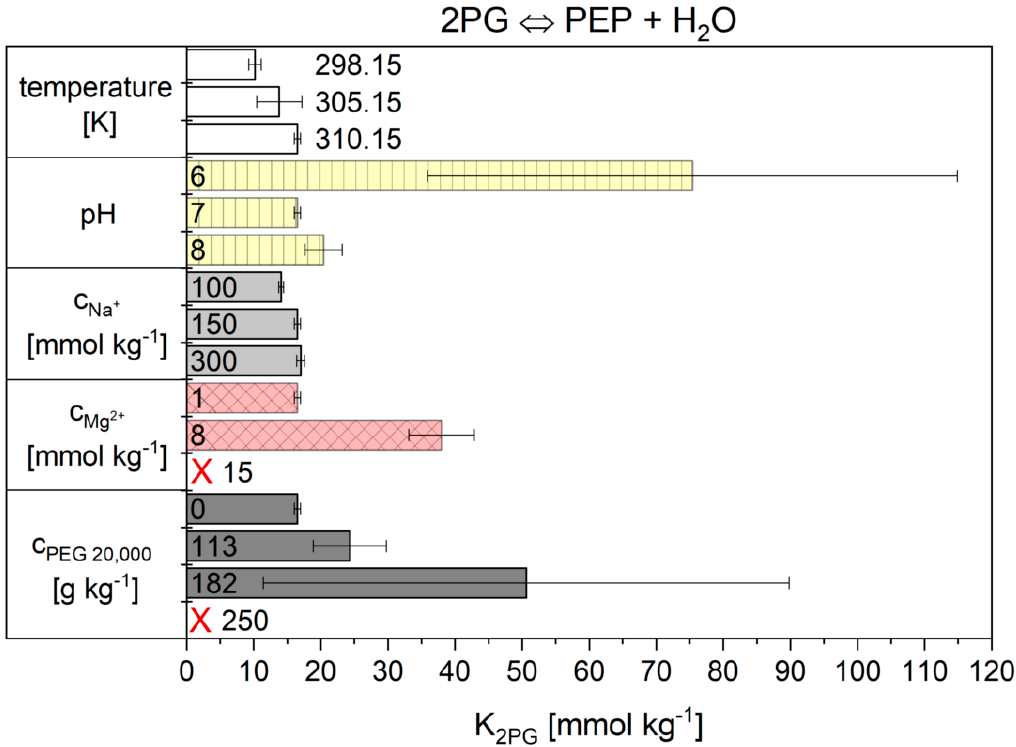
Figure 5. Values obtained for reaction 9 from the Noor model. The error bar results from the standard deviation of the triple determination of each measurement condition.